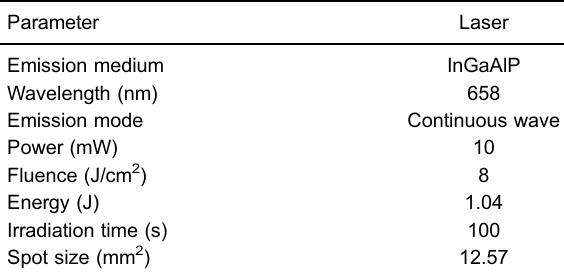
Table 1. Low-level laser therapy